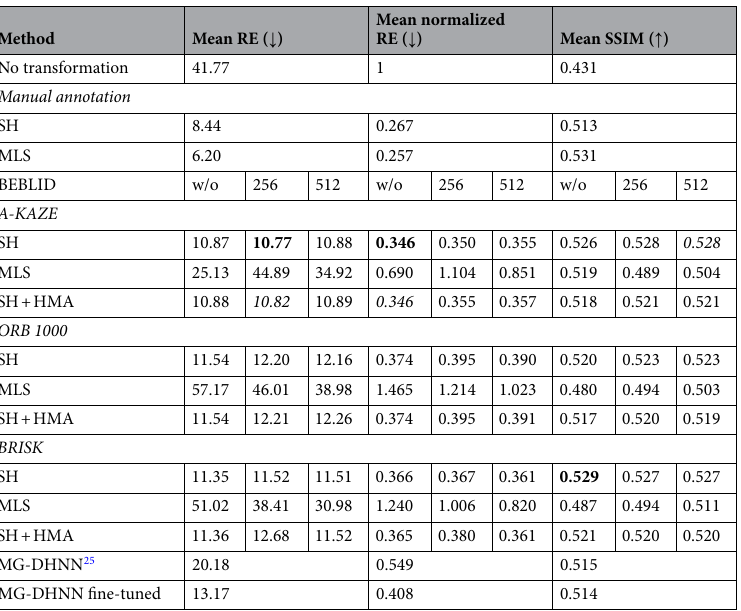
Table 1. Quantitative comparison of the tested methods. First and second-best solution are printed in bold and italic